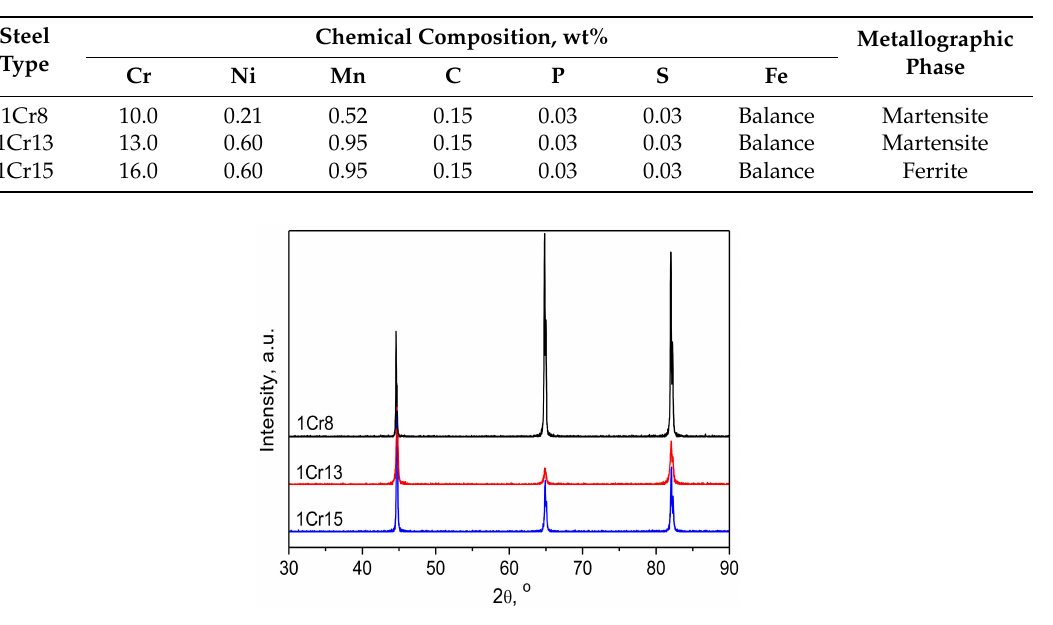
Table 1. The nominal chemical composition and metallographic phase of Cr steels.